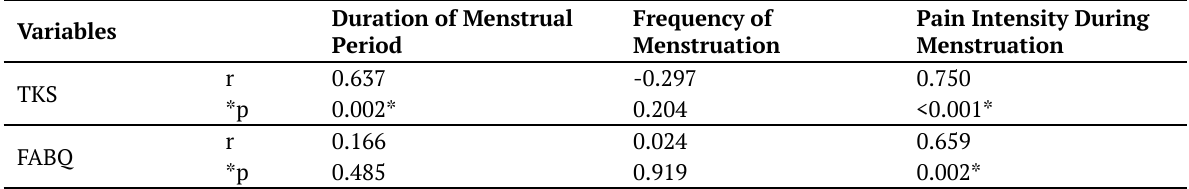
Table 4. The correlation analysis of the parameters in Group 1 experiencing pain during menstruation